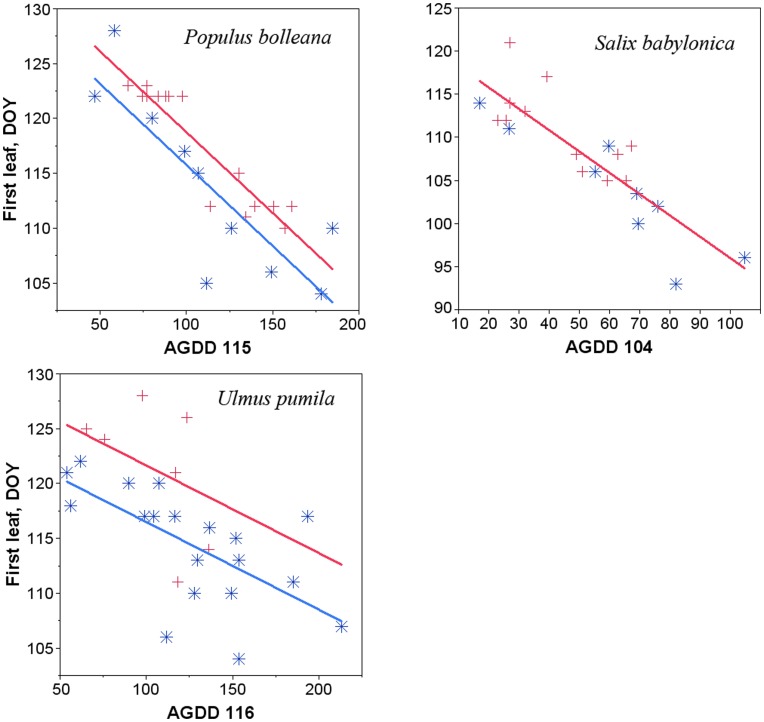
Graphical representation of ANCOVA analysis for the leaf emergence phenophase.Historical data are depicted by blue star symbols and spatial data by red crosses. Linear fits (either a single or two parallel lines) are selected based on ANCOVA. X axis is the growing degree days accumulated to a specified day of year.